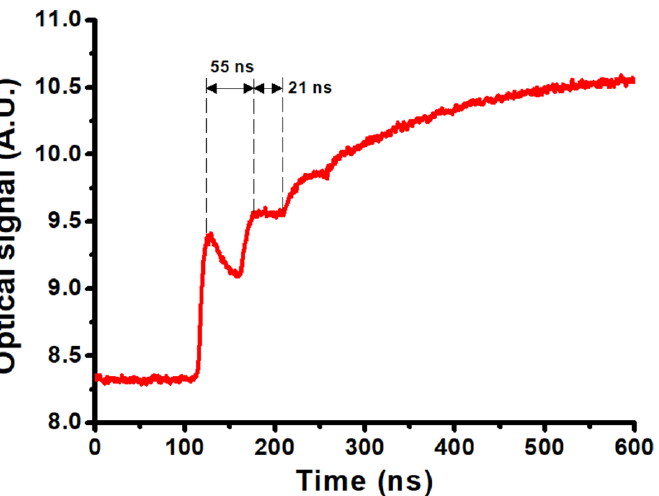
Figure 4. Optical signal of laser-induced plasmonic nanobubbles in 200 ppm GNRs colloid (SPR: 966 nm) irradiated by 980 nm pulsed laser of 80 mJ energy.